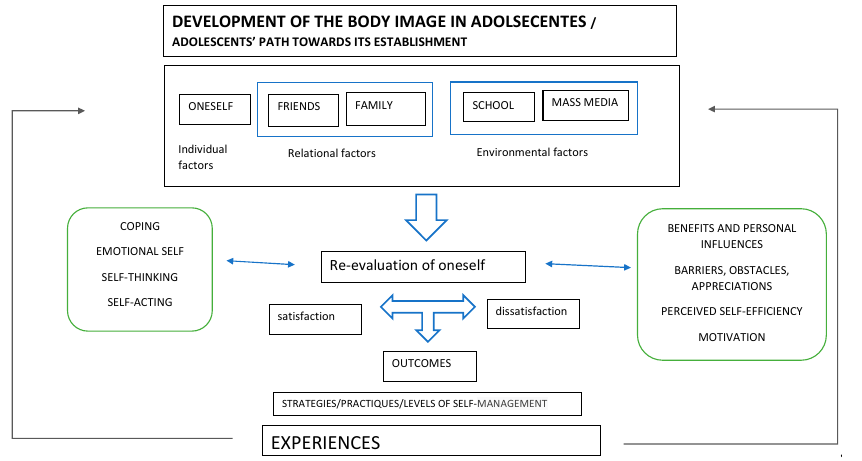
Figure 2. Line-of-argument: explanatory model.